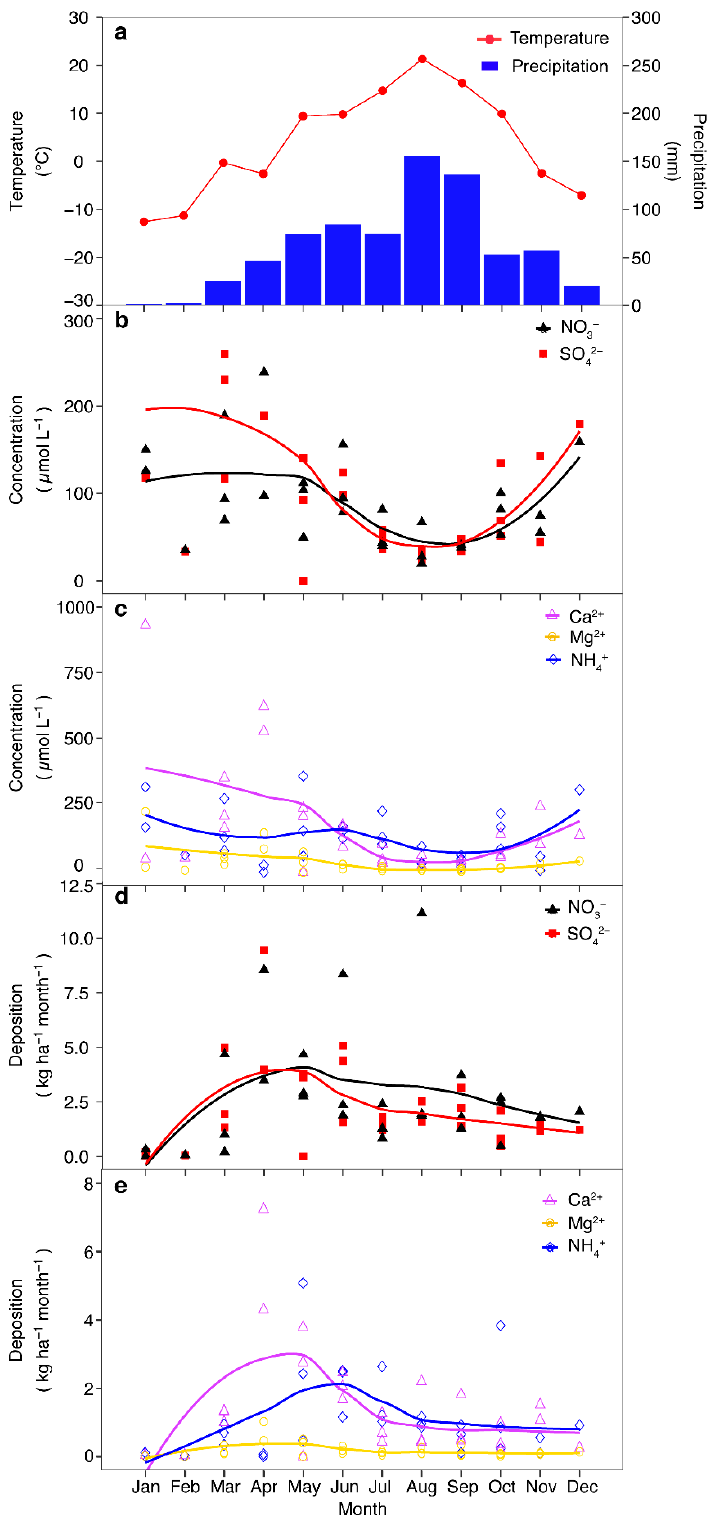
Figure 3. Monthly mean temperature and monthly mean precipitation amount ( a ), monthly mean concentrations ( b , c ), and monthly deposition rates ( d , e ) of major ions in precipitations in the Qingyuan forest over the period of 2018–2020. Each line in figures ( b – e ) indicates the loess-smoothed curve to show the monthly trends of the variables shown by the corresponding colour. The calcium ion concentration values in February 2018, January 2019, and February 2019 are missing because of the lack of enough samples for analysis.